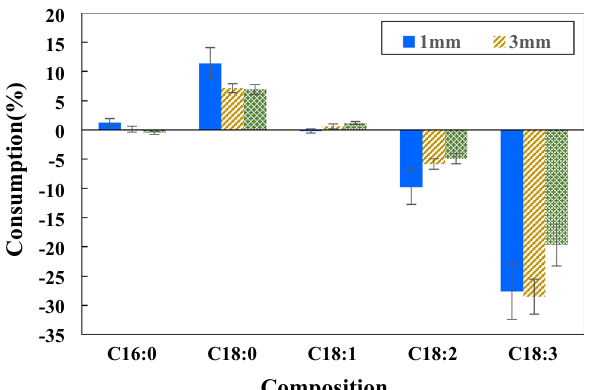
Figure 3. Effect of gas-filled gap on FAME composition changes (100 W and 25%H 2 at room temperature for 1